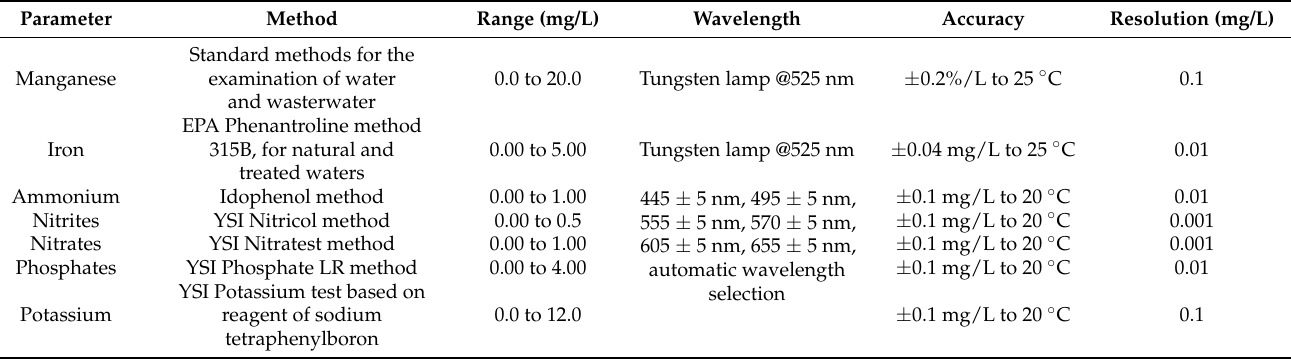
Table 1. Parameter description, method, range, wavelength, accuracy, and resolution of the YSI 9500 and HANNA 83,200